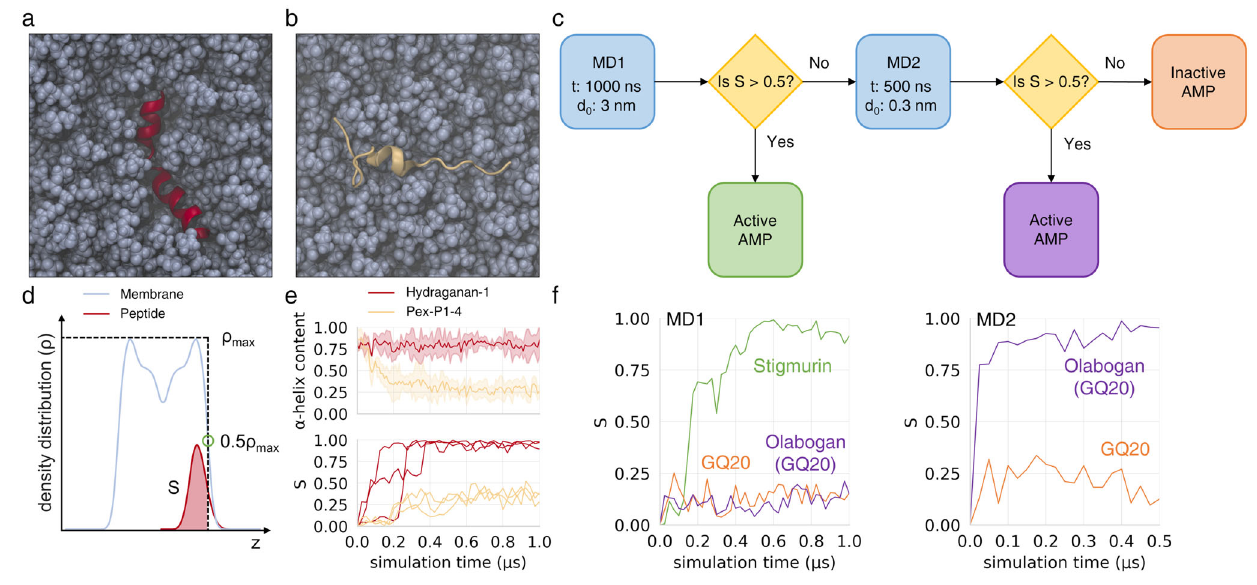
Fig. 6 | Summary of atomistic molecular dynamics simulations of peptide- membranesystems.a,b Latesimulationsnapshotsofexperimentallyveri fi edAMP Hydraganan-1 (red) and non-AMP peptide Pex-P1-4 (beige), respectively, in the membrane (blue); top view on membrane surface; water molecules not depicted for clarity; c scheme of optimized simulation protocol used for AMP preselection; t -- simulation time; d 0 initial peptide-membrane separation; d scheme illustrating the evaluation of the S parameter that describes the level of peptide burial within the membrane; z -- membrane normal axis; e system descriptors in Hydraganan-1